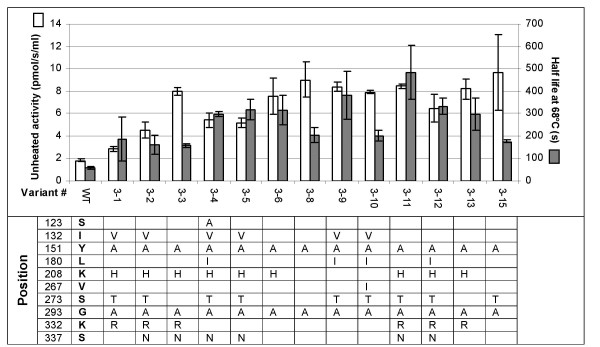
Changes in activity and half-life in designed protein variants. Activity (unheated) and half life were calculated for 13 protein variants and wild type proteinase K. The activity without heating was calculated from the initial slopes of the A405 measurements without heating (white bars), examples shown in Figure 6. The half-life at 68°C (shaded bars) was calculated using the initial slopes after different heating times and fitting to an exponential curve. Error bars represent one standard deviation of the experimental measurements. The wild-type values are shown on the left. The substitutions of each variant are given in the column below the variant name. Only 10 of the 19 positions are shown. In the remaining 9 positions, all variants contained amino acids from the wild-type sequence.